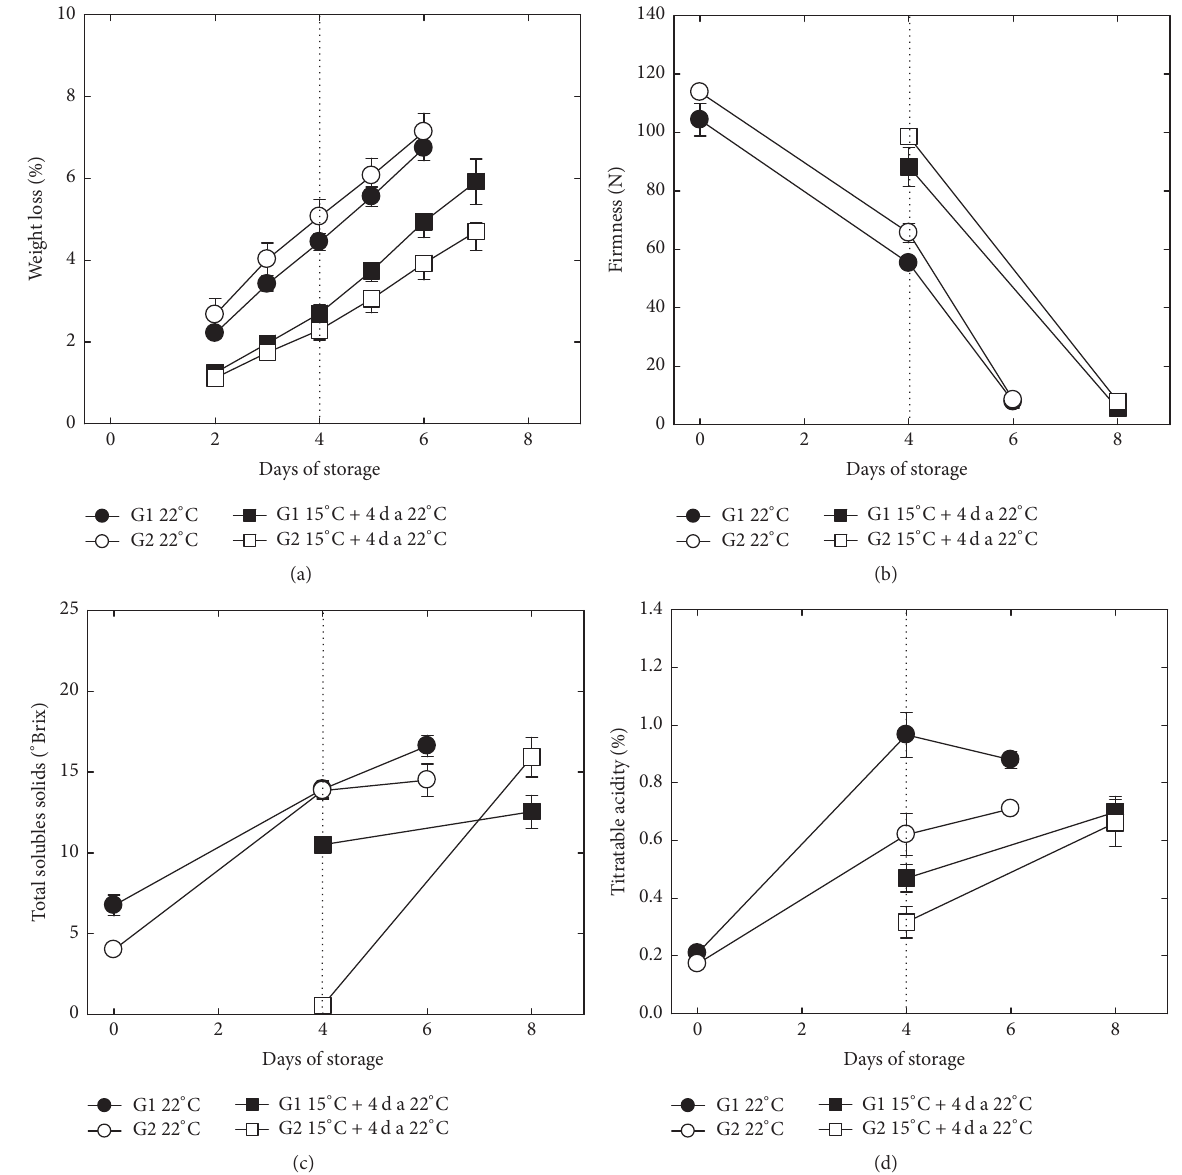
Figure 2: Mass loss behavior (a), firmness (b), total soluble solids (c), and titratable acidity (d) in two soursop selections stored at 22 ∘ C and 15 ∘ C. Each point represents the average of 6 observations and its standard error. The dotted line indicates the end of the refrigeration period.